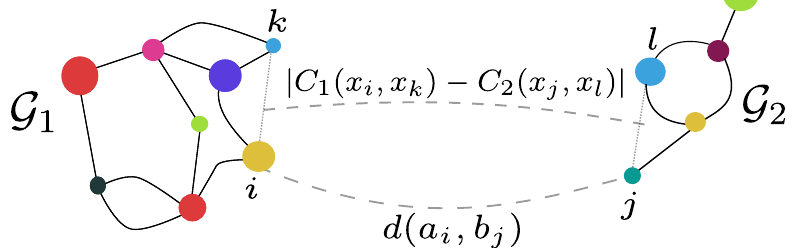
Figure 9. FGW loss for a coupling π depends on both a similarity between each feature of each node of each graph ( d ( a i , b j )) i , j and between all intra-graph structure similarities ( | C 1 ( i , k ) − C 2 ( j , l ) | ) i , j , k , l .